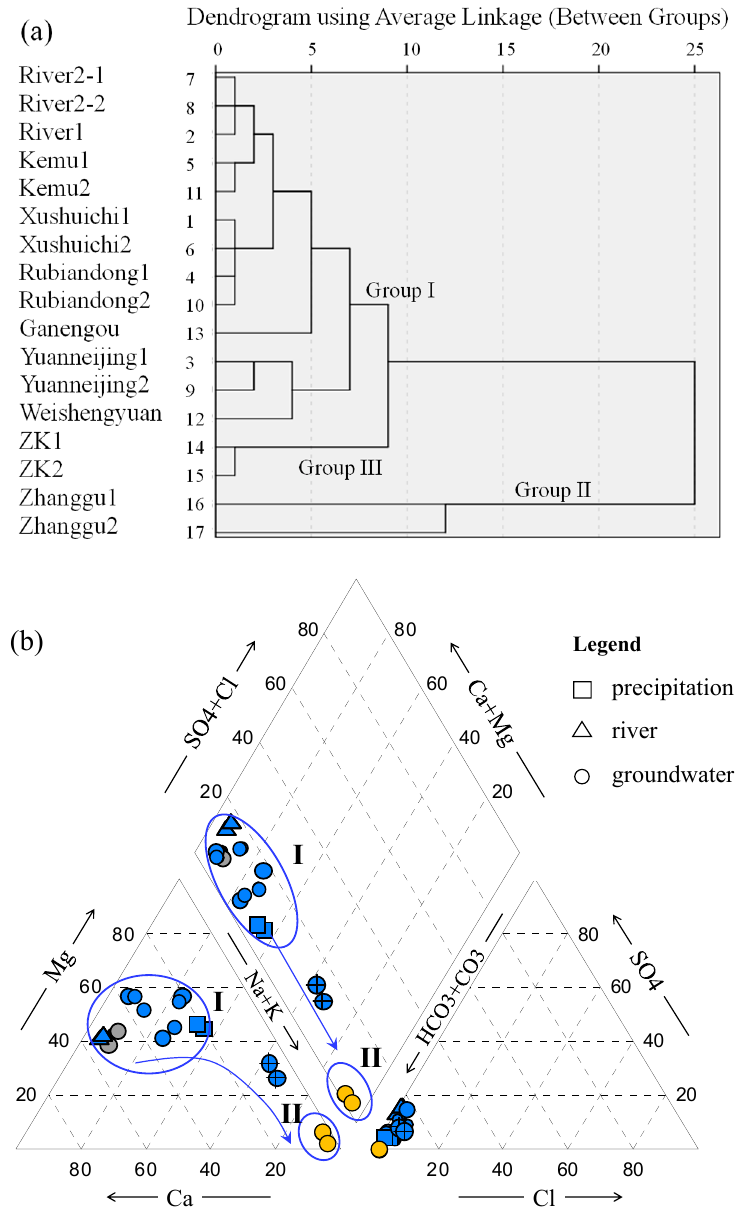
Figure 2. ( a ) Dendrogram showing the three groups of the water samples; ( b ) Piper plot of all 19 water samples collected in two sampling campaigns. Squares are rain samples, triangles are river samples, circles are groundwater samples, and circles with a cross are the water samples at the borehole ZK. Yellow represents the spring at Zhanggu, grey represents the spring Kemu, and blue represents the